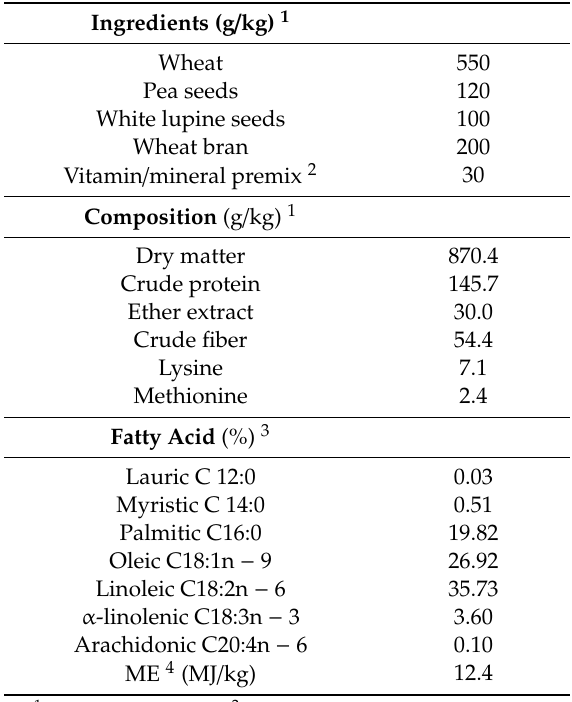
Table 2. Ingredients and nutritional composition of the experimental diet for both